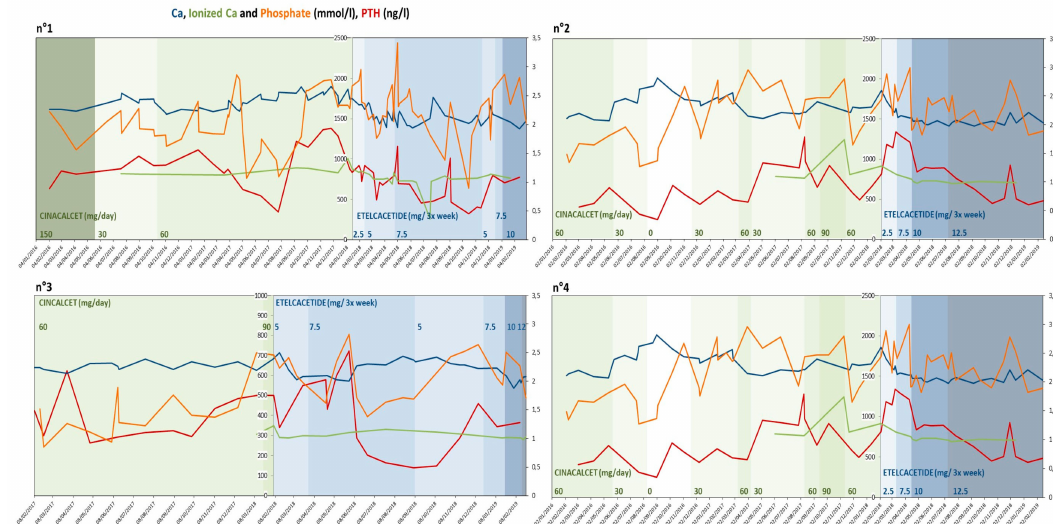
Figure 1. Variability of PTH, calcium and phosphate levels in the four patients with at least one year of follow-up. Legend: Ca Calcium; PTH parathyroid hormone. N: patient